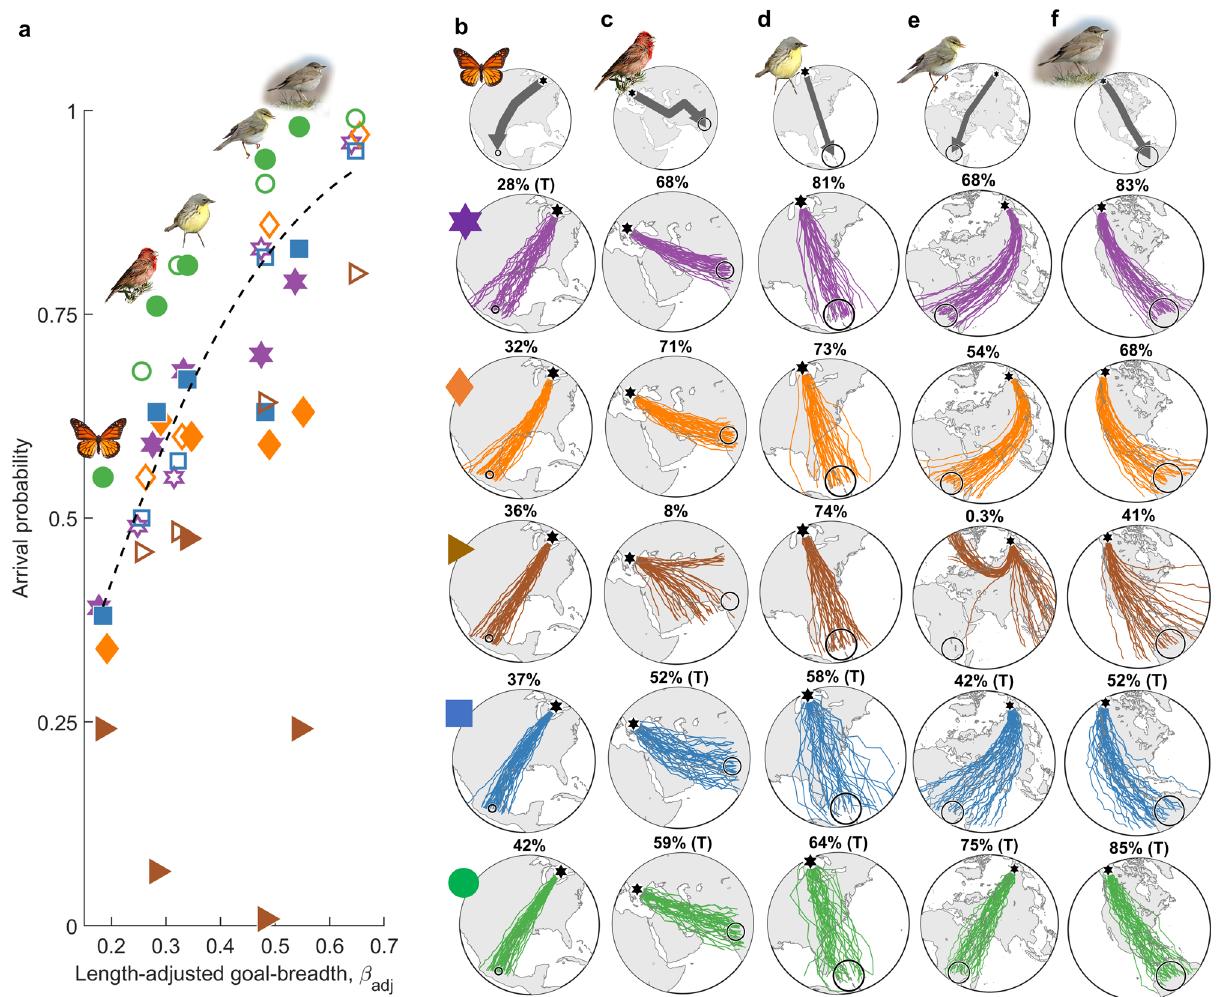
Fig. 4 Diverse compass course performance among species and migration routes. a Compass-course performance along known routes of nine airborne migrant species (Table 2) vs. length-adjusted goal breadth (Eq. (3)). Illustrated here based on 20° precision among fl ight-steps, with fi lled symbols representing (left-right) monarch butter fl y, common rose fi nch, Kirtland ’ s warbler ( Setophaga kirtlandii ), willow warbler and grey-cheeked thrush, and open symbols representing the other species (depicted in Supplementary Fig. 2). Purple hexagons represent geographic loxodromes, orange diamonds geomagnetic loxodromes, brown triangles magnetoclinic courses, blue squares fi xed sun compass courses and green circles time-compensated sun compass (TCSC) courses. b – f Randomly sampled trajectories (from 10,000 modelled individuals) with route-optimal population-mean headings for the above species, with colours and symbols representing compass-course as in a , for the above-named species (with the others depicted in Supplementary Fig. 2), assuming biologically relevant variability including 15° compass precision, drift, and 2.5° between-individual variability in inherited headings (see text). The top row depicts known species routes (grey arrows) between natal grounds (black hexagons) and natural goal areas (open circles), with straight lines appearing as great circles in the stereographic projection. Performance (percentage arrival) and, where applicable, also cue-transferred courses ( “ T ” ) are depicted above each panel. Photos by b D. Descousens (https://creativecommons.org/licenses/by-sa/2.0), c I. Shah (https://creativecommons.org/ licenses/by-sa/4.0), d B. Majoros (https://creativecommons.org/licenses/by-sa/3.0/), e HS and f A. D ’ (dashed purple line). Cue-transferred TCSC courses were how- ever relatively less affected by 20° within- fl ight drift (Fig. 6c), even outperforming non-transferred loxodromes for compass preci- sion within ca. 15° ( κ = 14.6, circular length = 0.97). Figure 6d depicts the effects of goal radius (km) and within-individual variability on the performance of geographical loxodromes with 20° compass precision in the absence of drift. Figure 6e, f illus- trate that the performance gain with TCSC courses over geo- graphic loxodromes is larger with larger between-individual variability, and for larger goal areas, particularly in presence of (20°) within- fl ight drift (Fig. 6f). The feasibility of TCSC courses across broad latitudinal